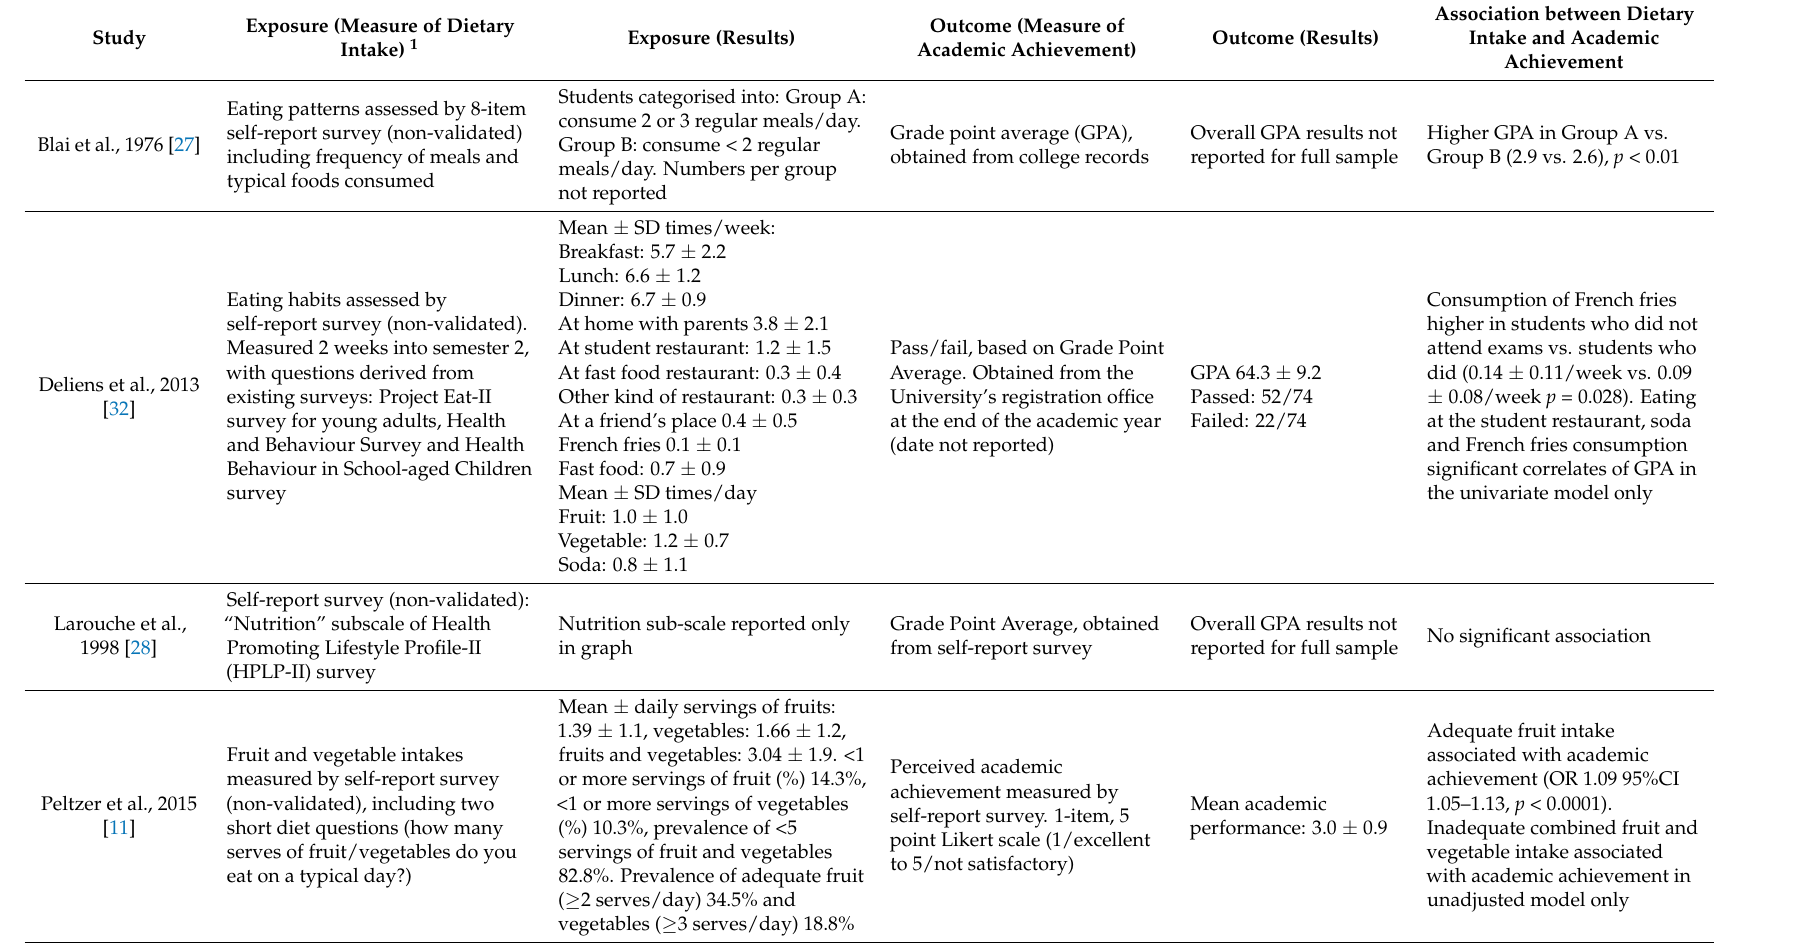
Table 2. Dietary intake and academic achievement systematic review: Study